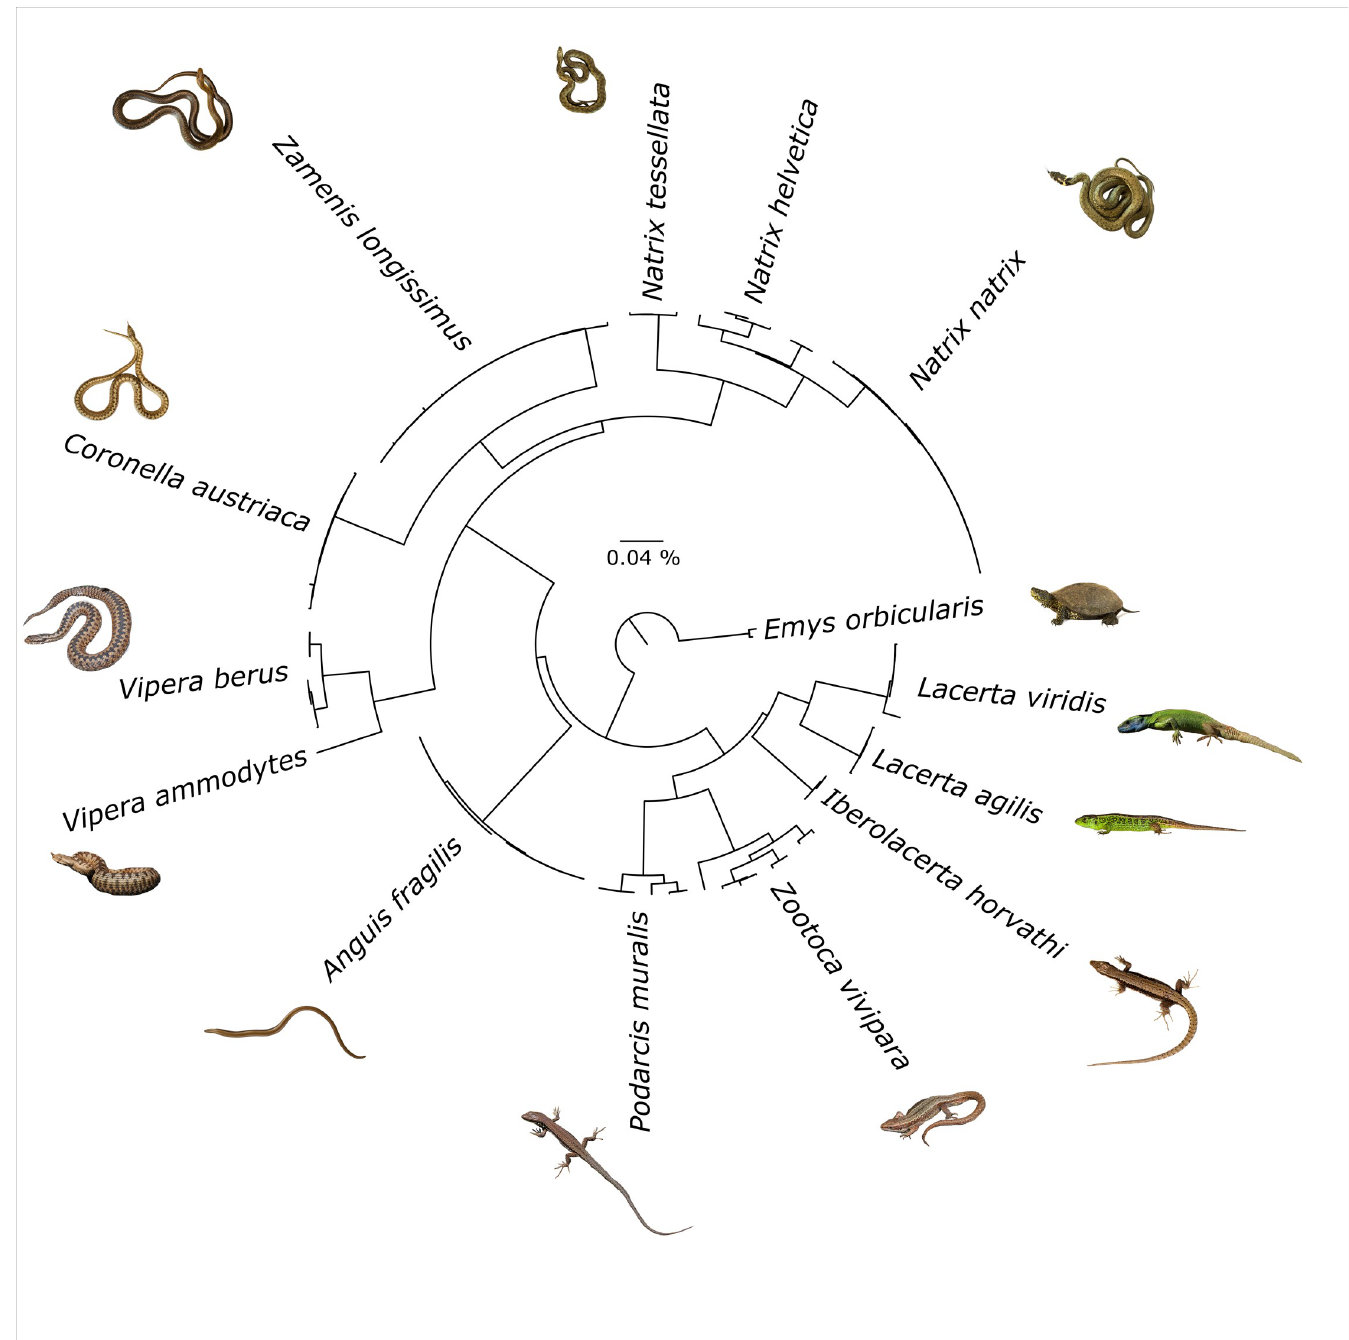
Fig 2. NJ tree of Austrian reptiles based on K2P distances. The tree was inferred with the “Taxon ID Tree” tool implemented in BOLD and visualized in FigTree v1.4.2 (http://tree.bio.ed.ac.uk/software/figtree/).